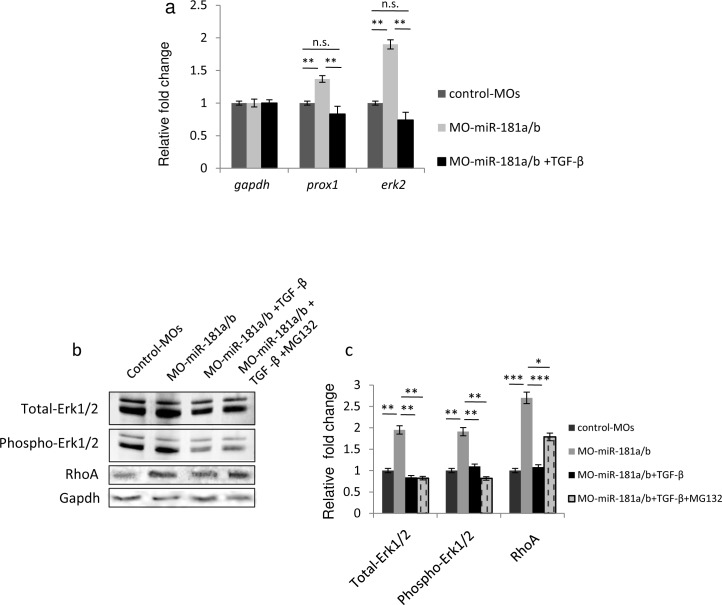
TGF-β signaling regulates RhoA levels via two independent and synergistic cascades.
(a) qRT-PCR analysis of erk2 transcripts in total eye RNA derived from St32 control-MOs, miR-181a/b morphants and TGF-β-treated miR-181a/b morphants. The TGF-β-mediated increase of miR-181a/b caused a rescue of miR-181a/b target transcripts, such as prox1 and erk2, in miR-181a/b morphants. (b, c) Representative Western blotting on protein from St32 eyes (b) and corresponding quantification (c) show that administration of TGF-β to MO-miR-181a/b embryos leads to restoration of total-, phospho-Erk2 and RhoA protein levels. When MO-miR-181a/b embryos were treated with both TGF-β and the proteasomal inhibitor MG132, total- and phospho-Erk2 protein levels were still rescued, whereas RhoA levels were only partially rescued. Data are means +SEM.* P <0.05; **P <0.01; *** P <0.001 (two-way ANOVA).